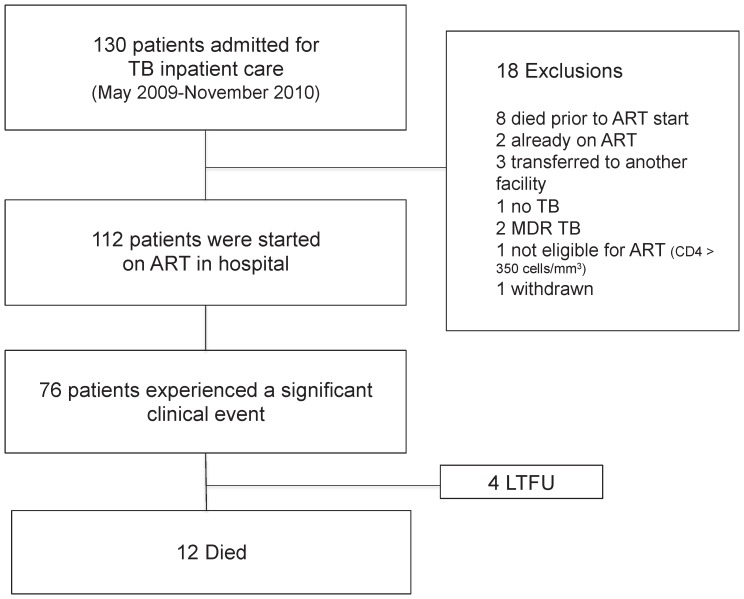
Patient enrollment.LTFU = lost to follow-up, TFO = transferred out.